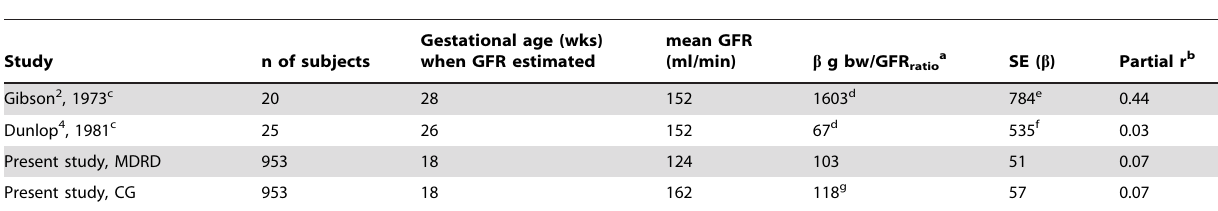
Table 3. Relationship between glomerular filtration rate (GFR in pregnancy and birth weight, estimated in three